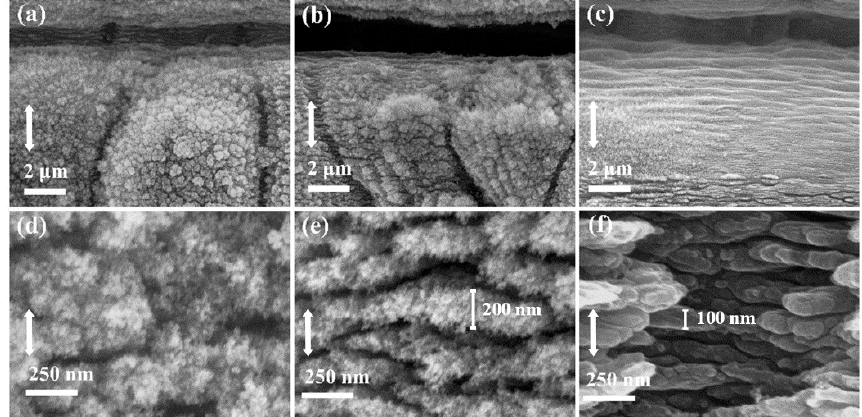
Figure 4. SEM images of surface structures. Here, the laser pulse energy for sample ( a – c ) is 0.93 μ J, 1.52 μ J and 2.06 μ J, respectively; ( d – f ) are high-magnification SEM image corresponding to ( a – c ). Double headed solid arrow represents incident laser polarization.